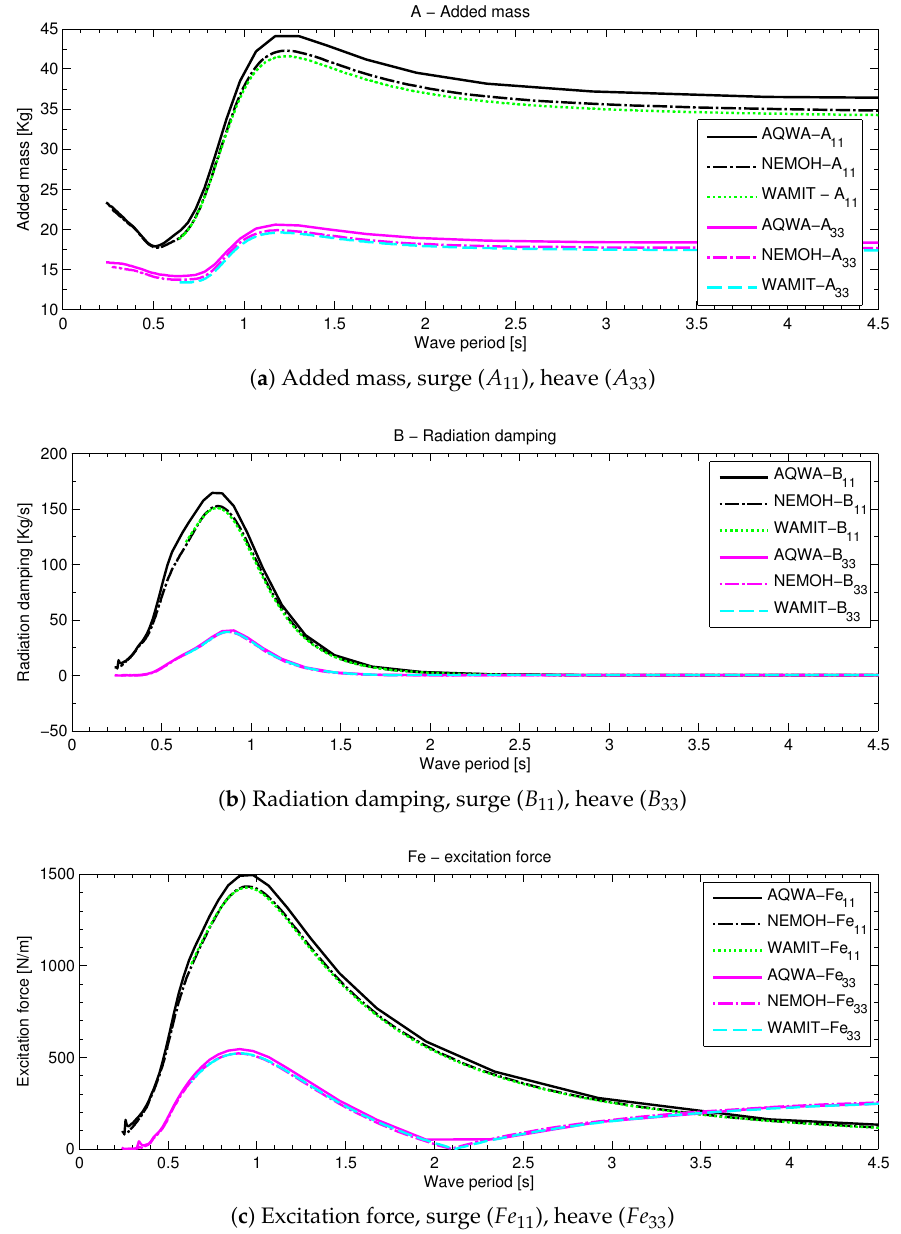
Figure 2. Frequency-dependent hydrodynamic properties of the